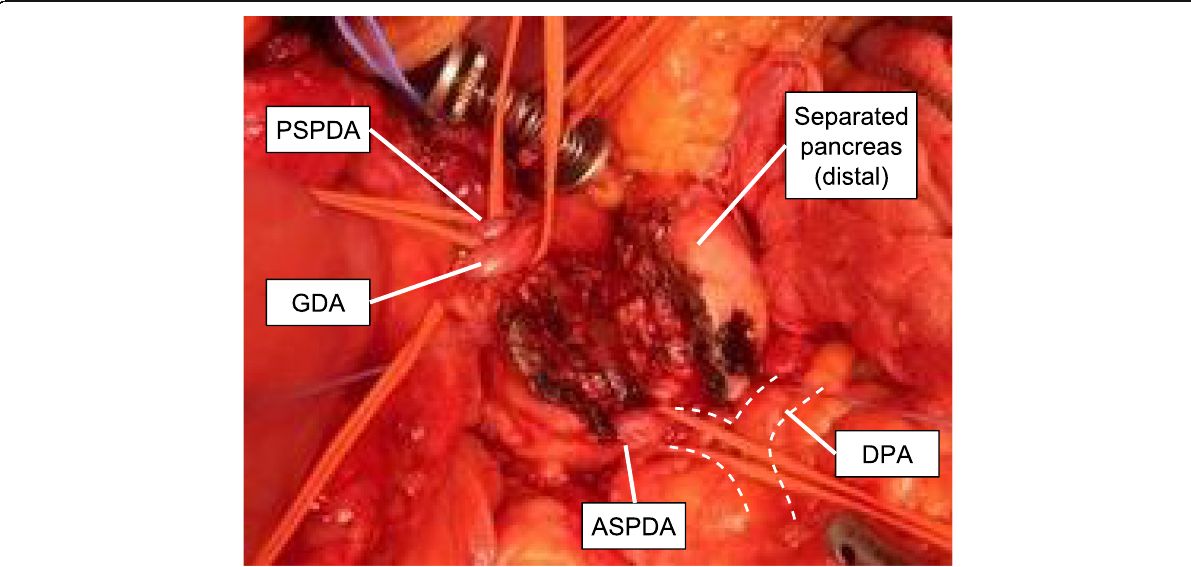
Fig. 4 Intraoperative photograph after taping the ASPDA, GDA, and PSPDA. Enlarged arterial communications around the pancreas were identified. The position of the DPA was confirmed by palpation and intraoperative ultrasonography. ASPDA, anterior superior pancreaticoduodenal artery; DPA, dorsal pancreatic artery; GDA, gastroduodenal artery; PSPDA, posterior superior pancreaticoduodenal